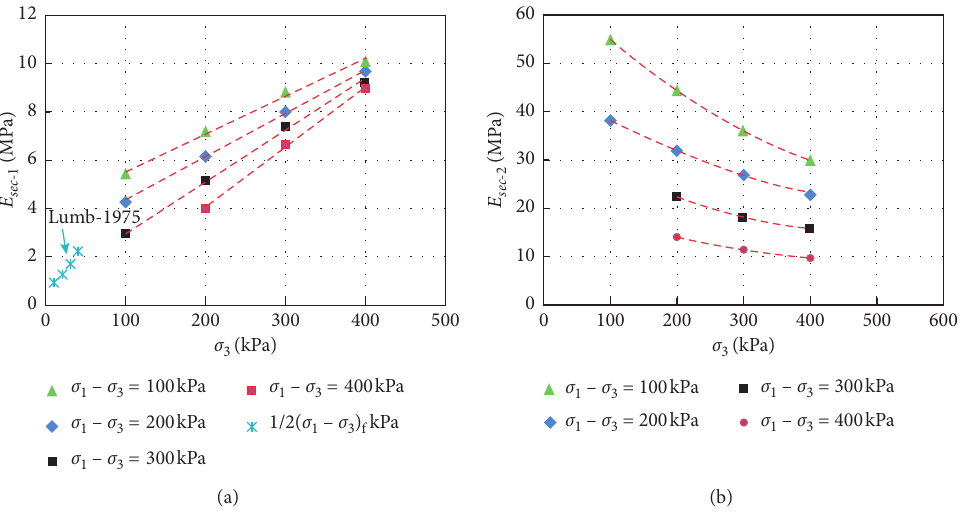
Figure 10: Correlation between secant modulus and confining pressure: (a) E